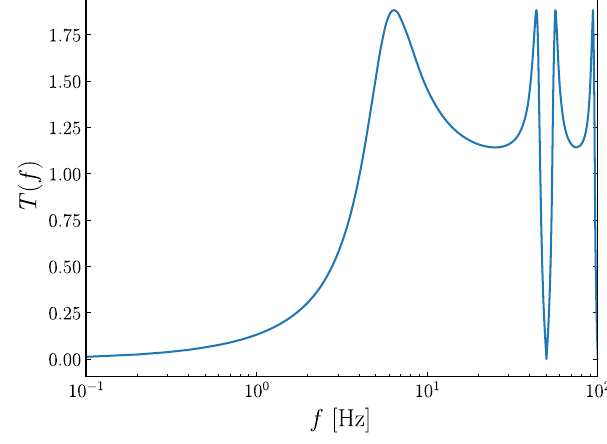
FIG. 10. PSD P ð f Þ vs frequency f of ground motion model D.